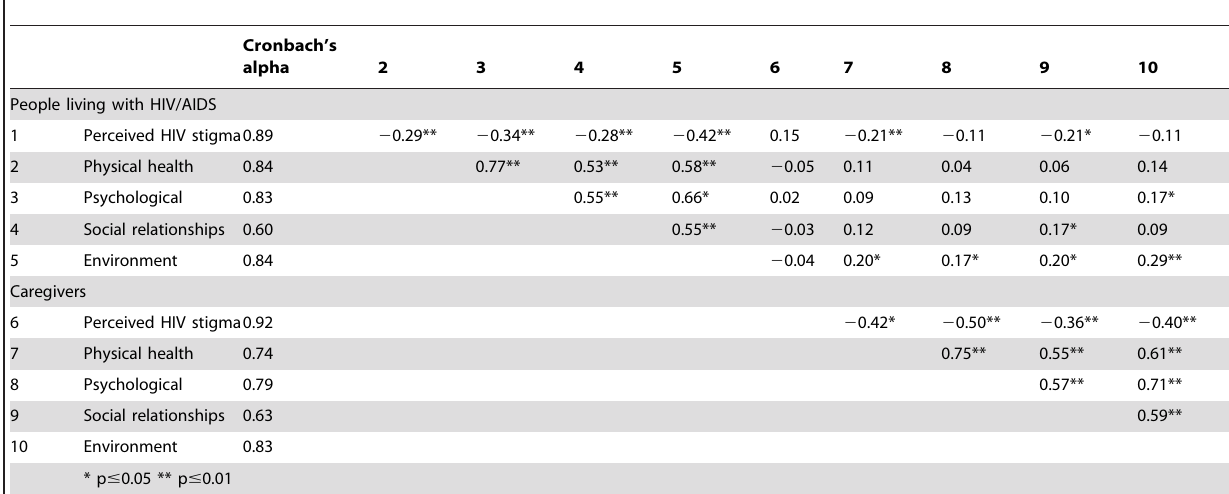
Table 2. Correlations among perceived HIV stigma and four domains of quality of life.